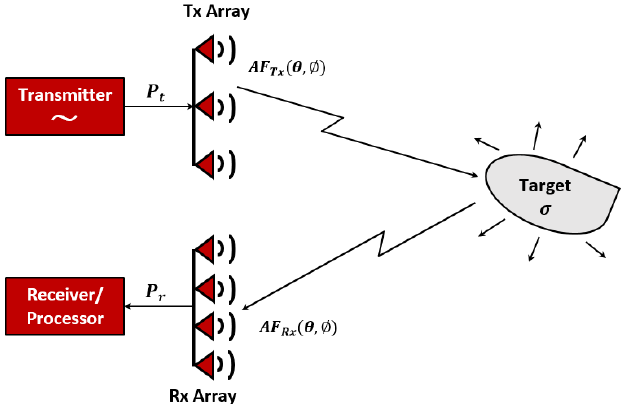
Figure 1. A schematic diagram of the general radar system.